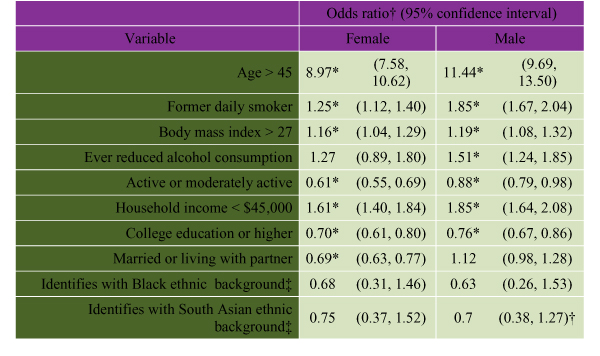
Bootstrapped Logistic Regression Analysis for Variables Associated With Self-Reported Heart Disease in Canadian Females and Males. The odds ratio estimates and their associated confidence intervals were calculated using the Statistics Canada bootstrap weights for the CCHS and the SAS macro program, which was written for that purpose. ‡ Black and South Asian ethnic status show odds ratios in the direction of a protective effect for both sexes, but the confidence intervals suggest that these are not statistically robust results. This could be because of a lack of statistical power. Despite the 130,000 respondent records in the CCHS, there are relatively few people represented with these ethnic backgrounds who report currently living with heart disease. Source: 2000 Canadian Community Health Survey (Statistics Canada) (This analysis is based on the Statistics Canada CCHS, Cycle 1.1, 2000. All computations on these data were done by Health Canada and the responsibility for the use and interpretation of these data is entirely that of authors.)